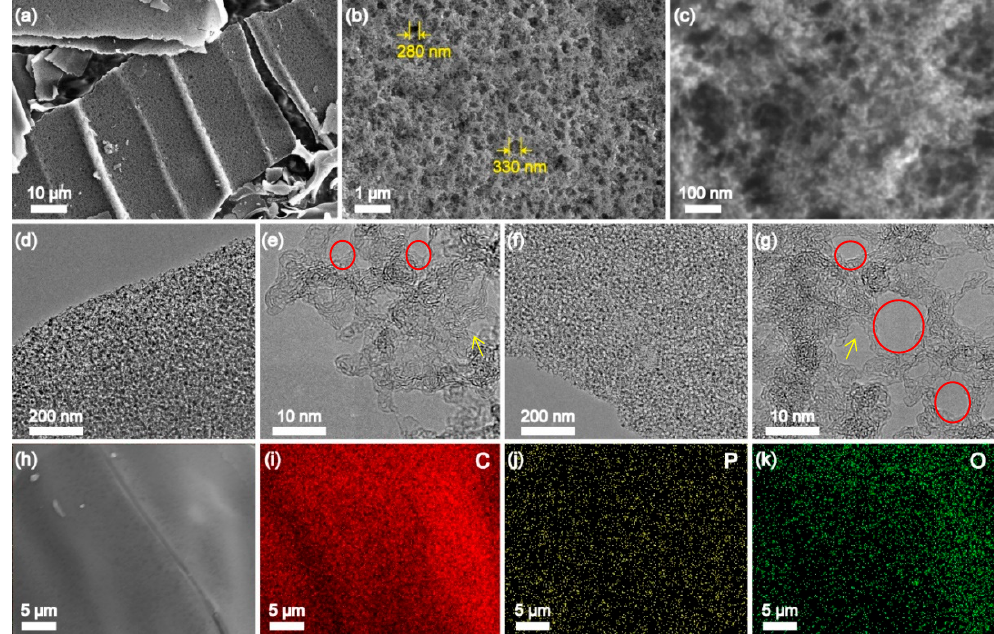
Figure 1. SEM images of HPC8 ( a – c ), TEM images for HPC8 ( d , e ) and HPC6 ( f , g ) and EDS element mapping for HPC8 ( h – k ). Table 1. Atomic percentage (at%) for each element in HPCs detected by EDS and